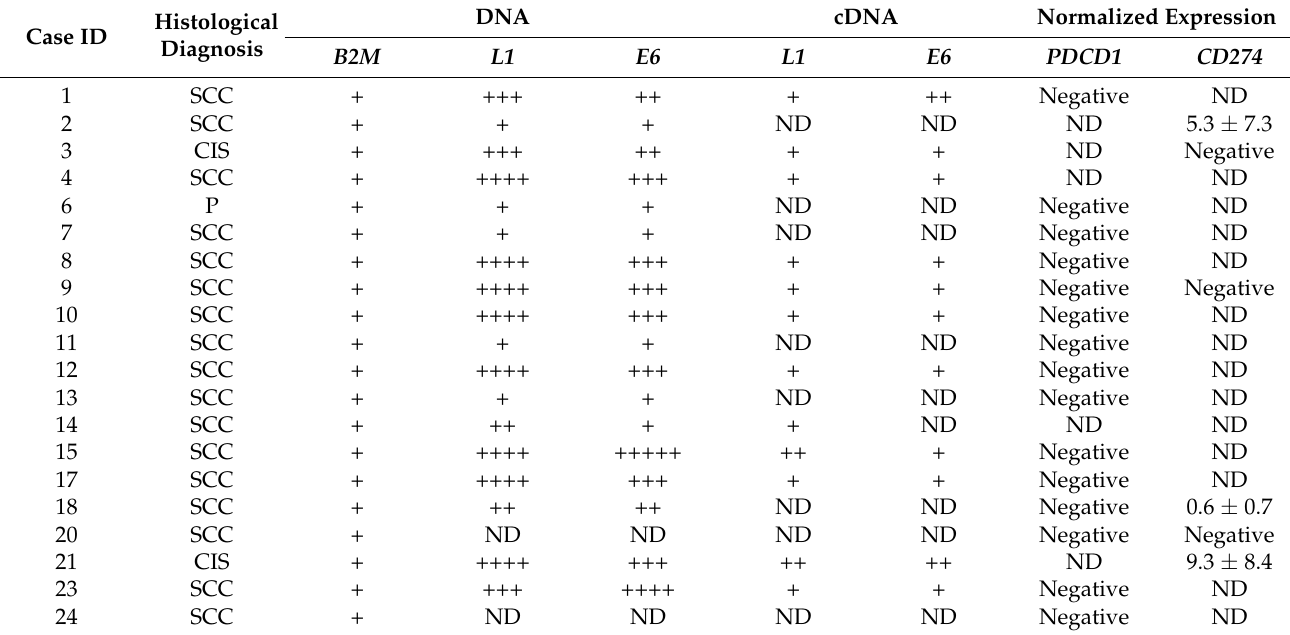
Table 2. Histological diagnosis: SCC: squamous cell carcinoma; CIS: carcinoma in situ; P: papilloma. Real-time PCR data for B2M are expressed as + (amplified). Viral DNA detection and gene expression were given indicating the mean Cq at which the positivity for L1 and E6 were detected: + (32–37 Cq), ++ (26–31 Cq), +++ (20–25 Cq), and ++++ (14–19 Cq), and ND (not detected). For equine genes, the mean of normalized expression ± 1 standard error of three replicates is reported for PDCD1 and CD274 ; samples with a mean Cq > 38 were considered